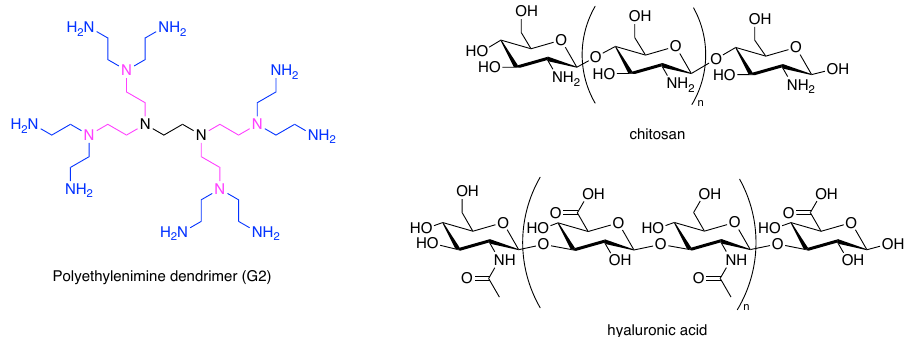
Figure 2. Structures of natural polysaccharide carriers and a synthetic dendrimer.